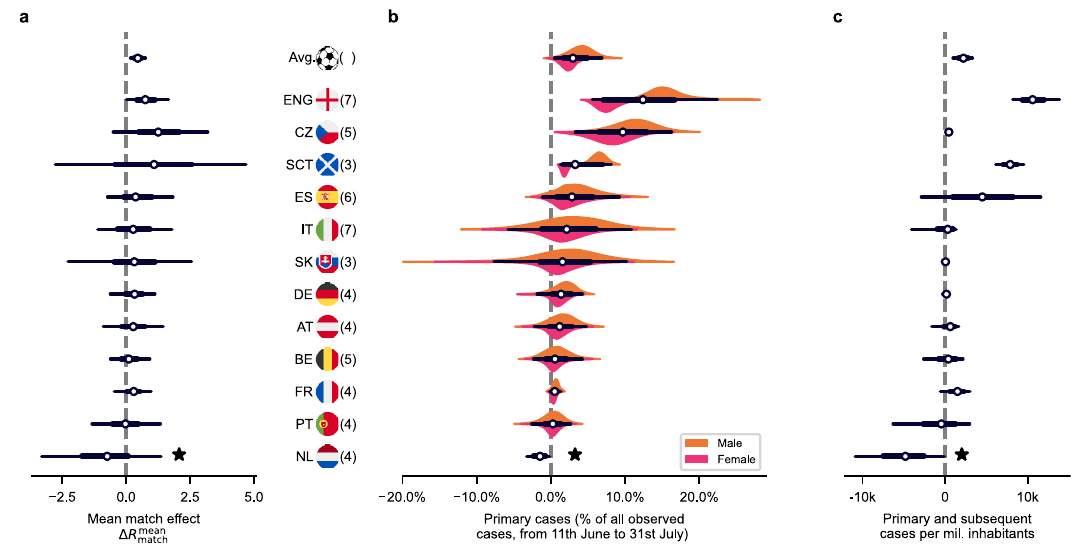
Fig. 1 | Quantifying the impact of the Euro 2020 on COVID-19 spread. a Using Bayesian inference and an SEIR-like model, we infer the mean increase on the reproduction number associated with Euro 2020 matches, Δ R mean match , in each ana- lyzed country ( n =12 countries). Almost all countries show a median of the mean